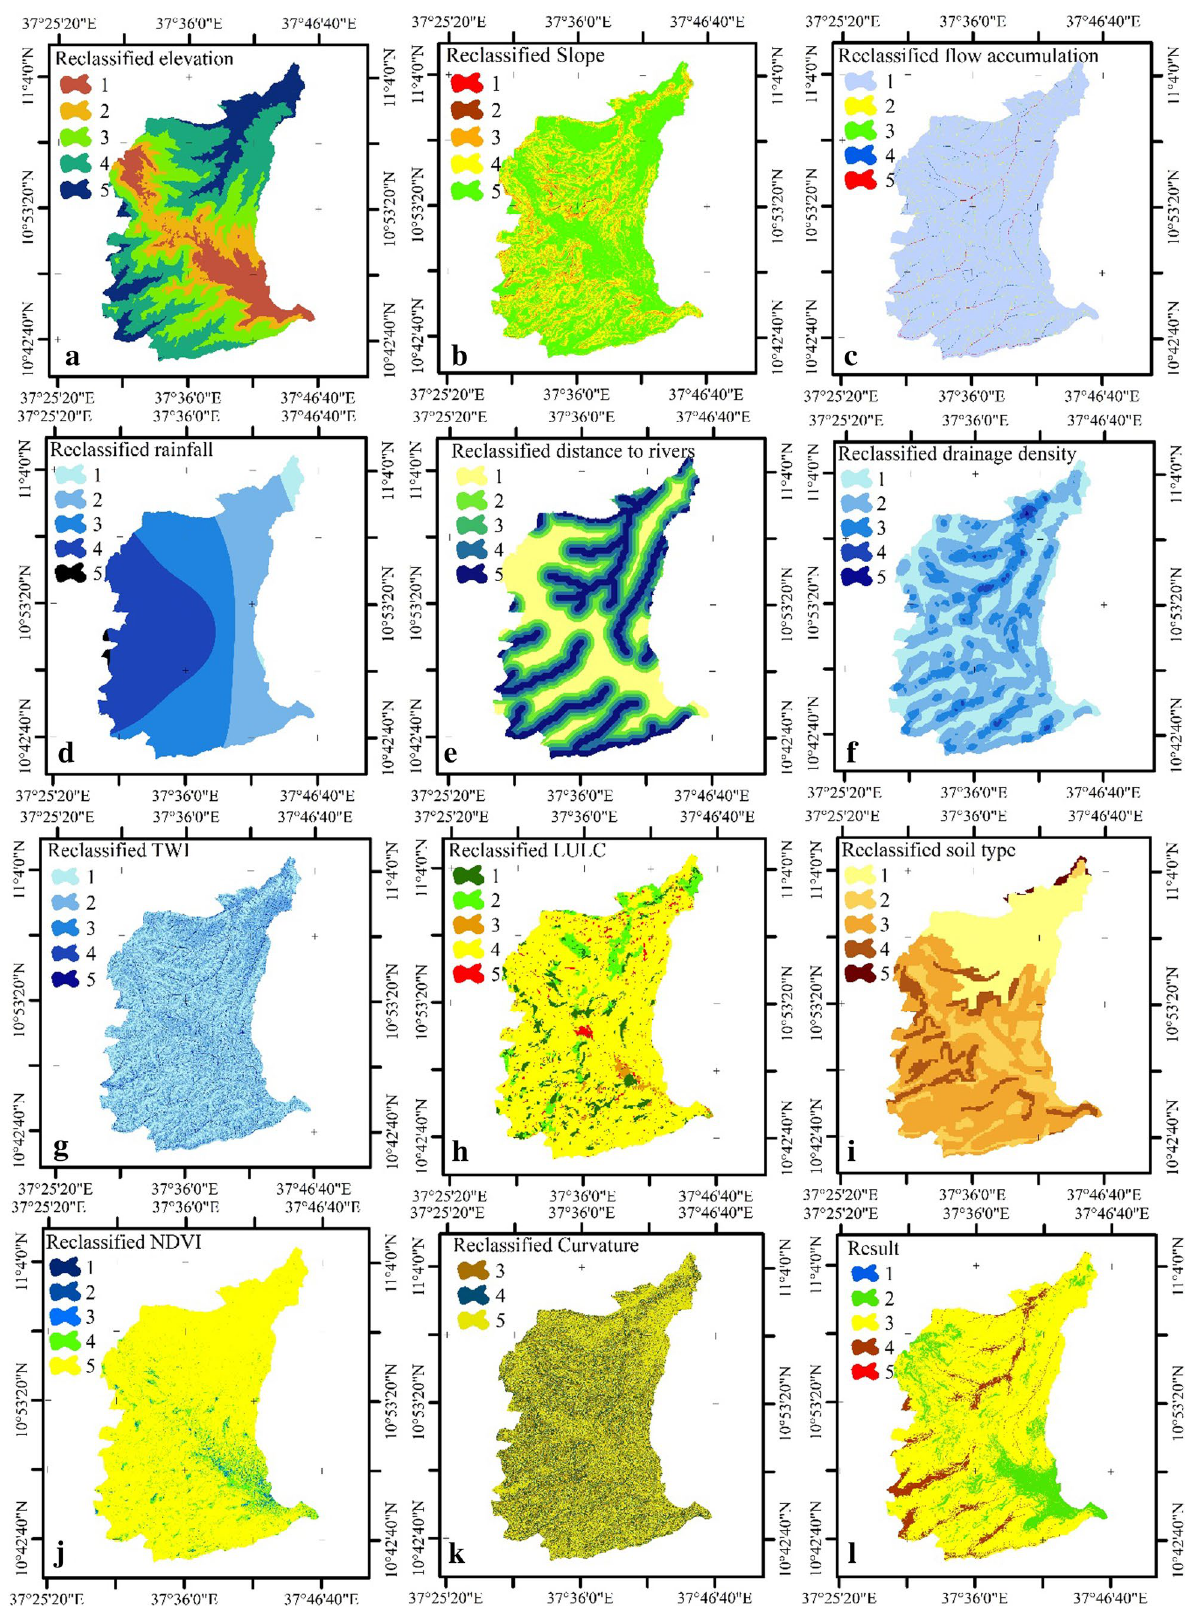
Fig. 6 Reclassification of flood-controlling factors (a-k) and result (l)